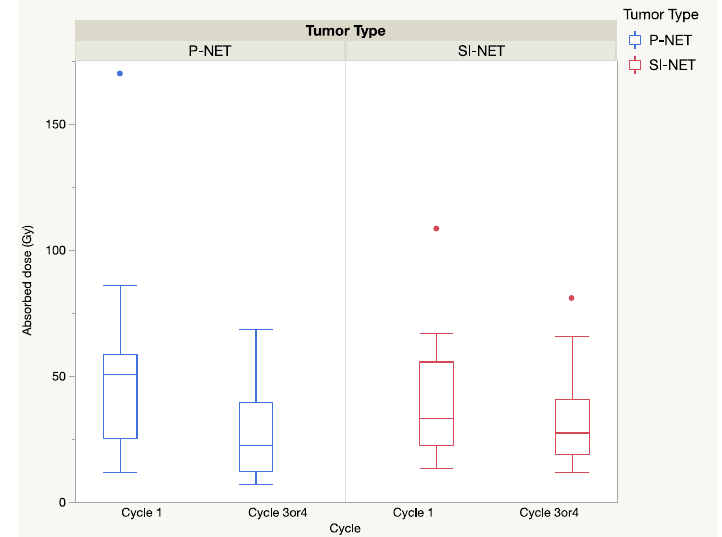
Figure 3. Absorbed dose (Gy) to the tumor at the first and the second cycle of full seven-day do- simetry (cycle 1 and 3/4) P-NENs ( n = 20) and SI-NENs ( n = 19).